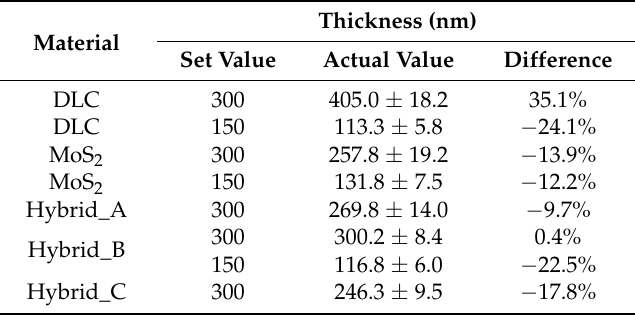
Table 2. Material and thickness of the